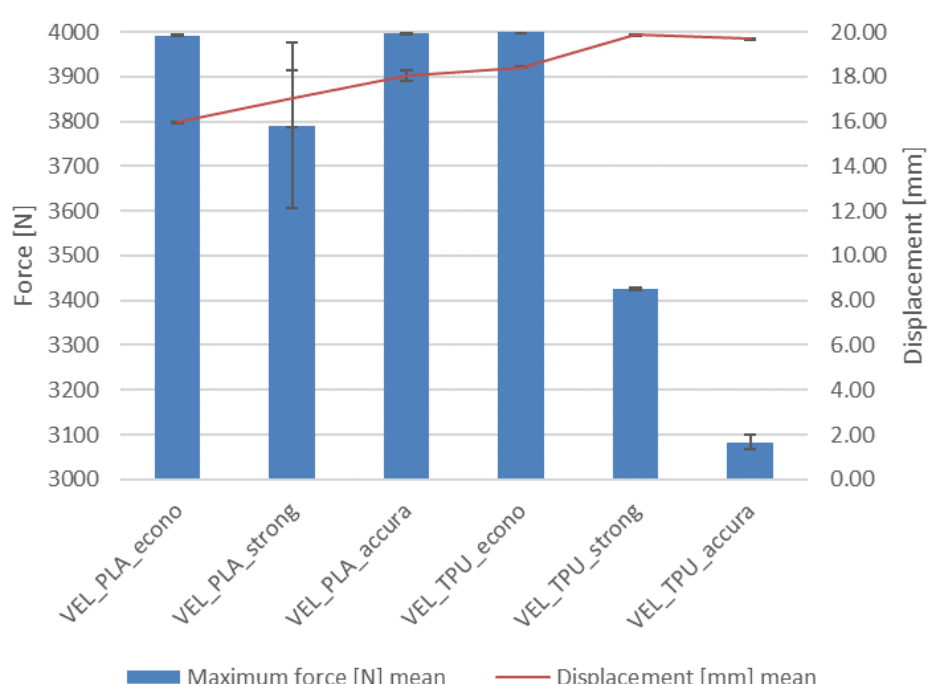
Figure 19. Strength test results for the vacuum sockets.